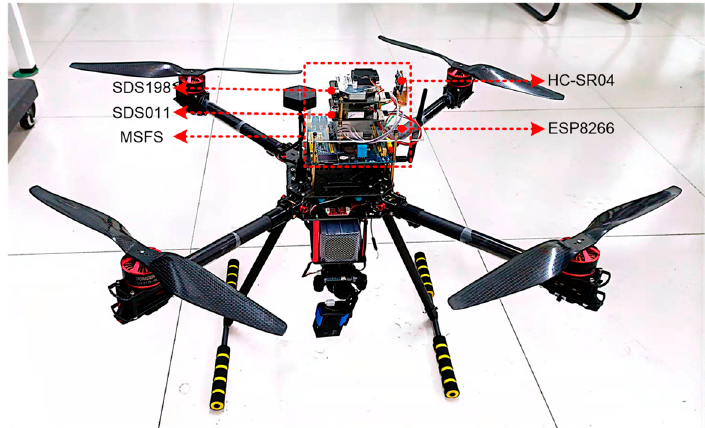
Figure 9. Assembled monitoring system.